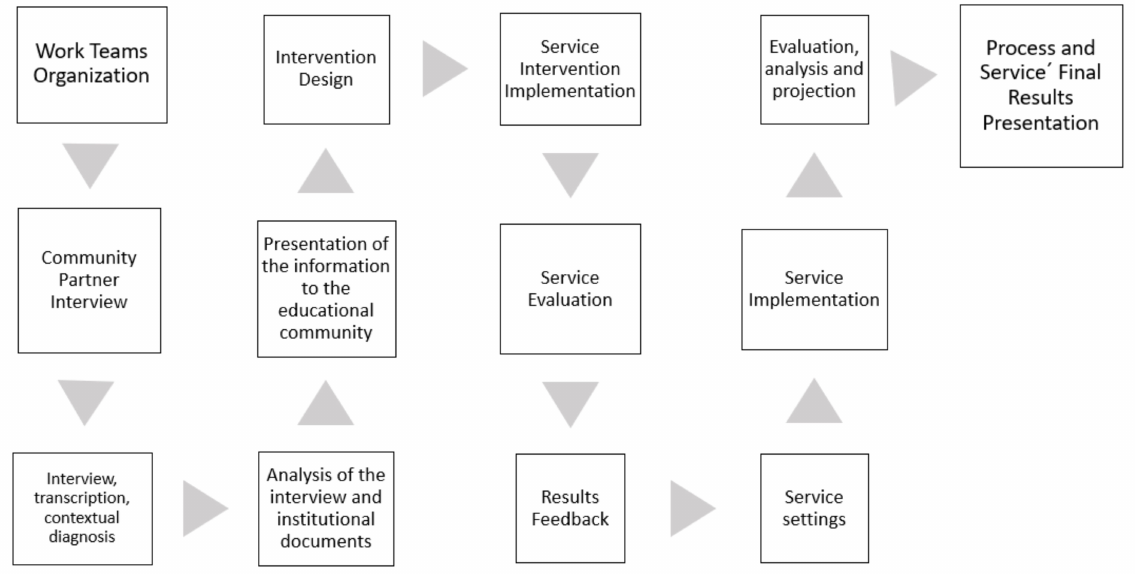
Figure 2. Activities considered for the development of this proposal (Authors’ creation).